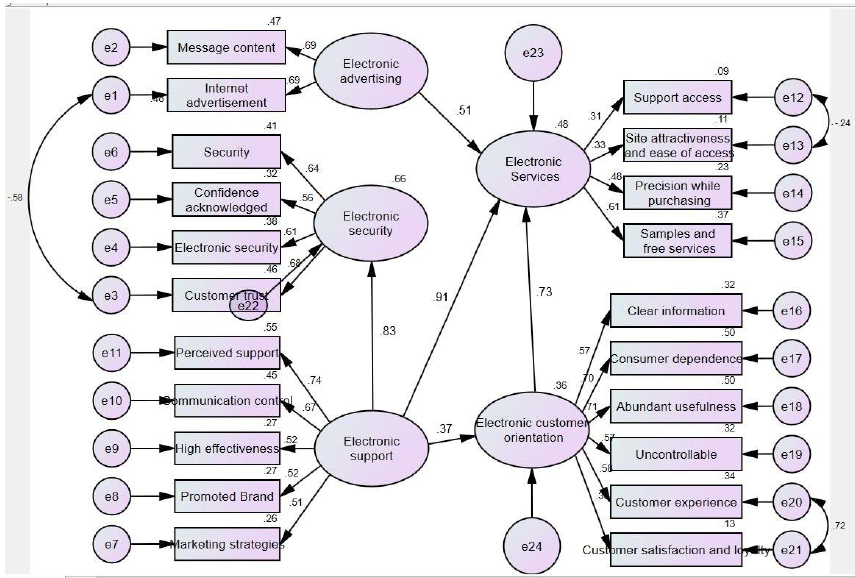
Table (3) shows the descriptive information (mean, standard